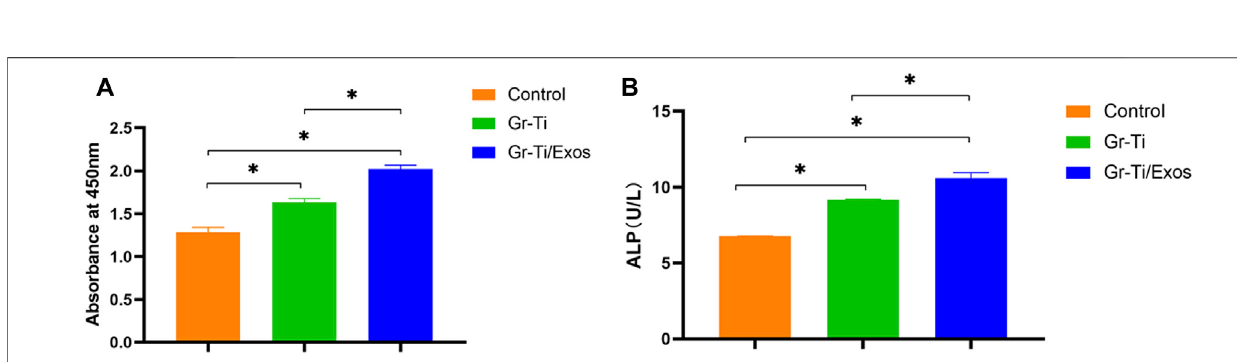
Frontiers in Bioengineering and Biotechnology |